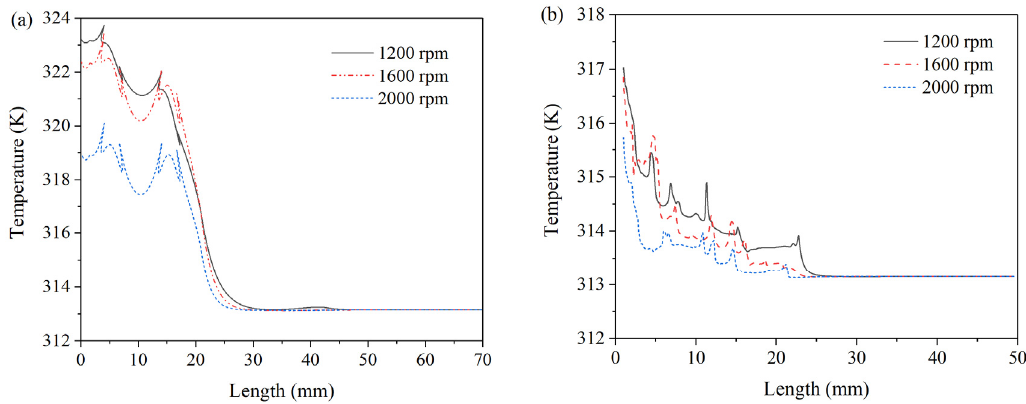
Figure 15. Temperature distribution along: ( a ) the outer wall; ( b ) the center line for different rotational speed.